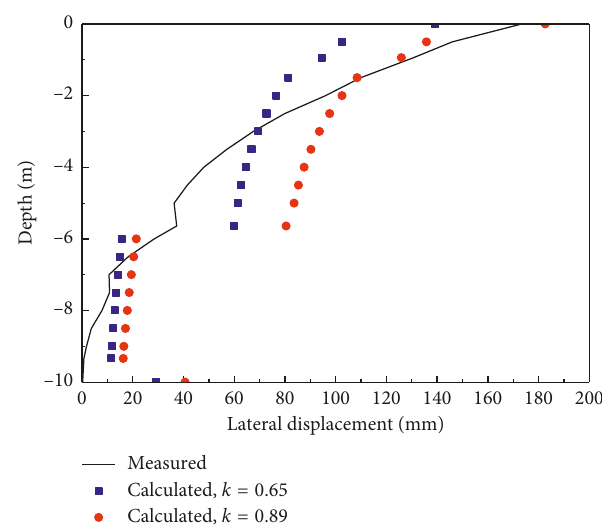
Figure 9: Lateral displacement at a distance of 20 m from Section 1 boundary.